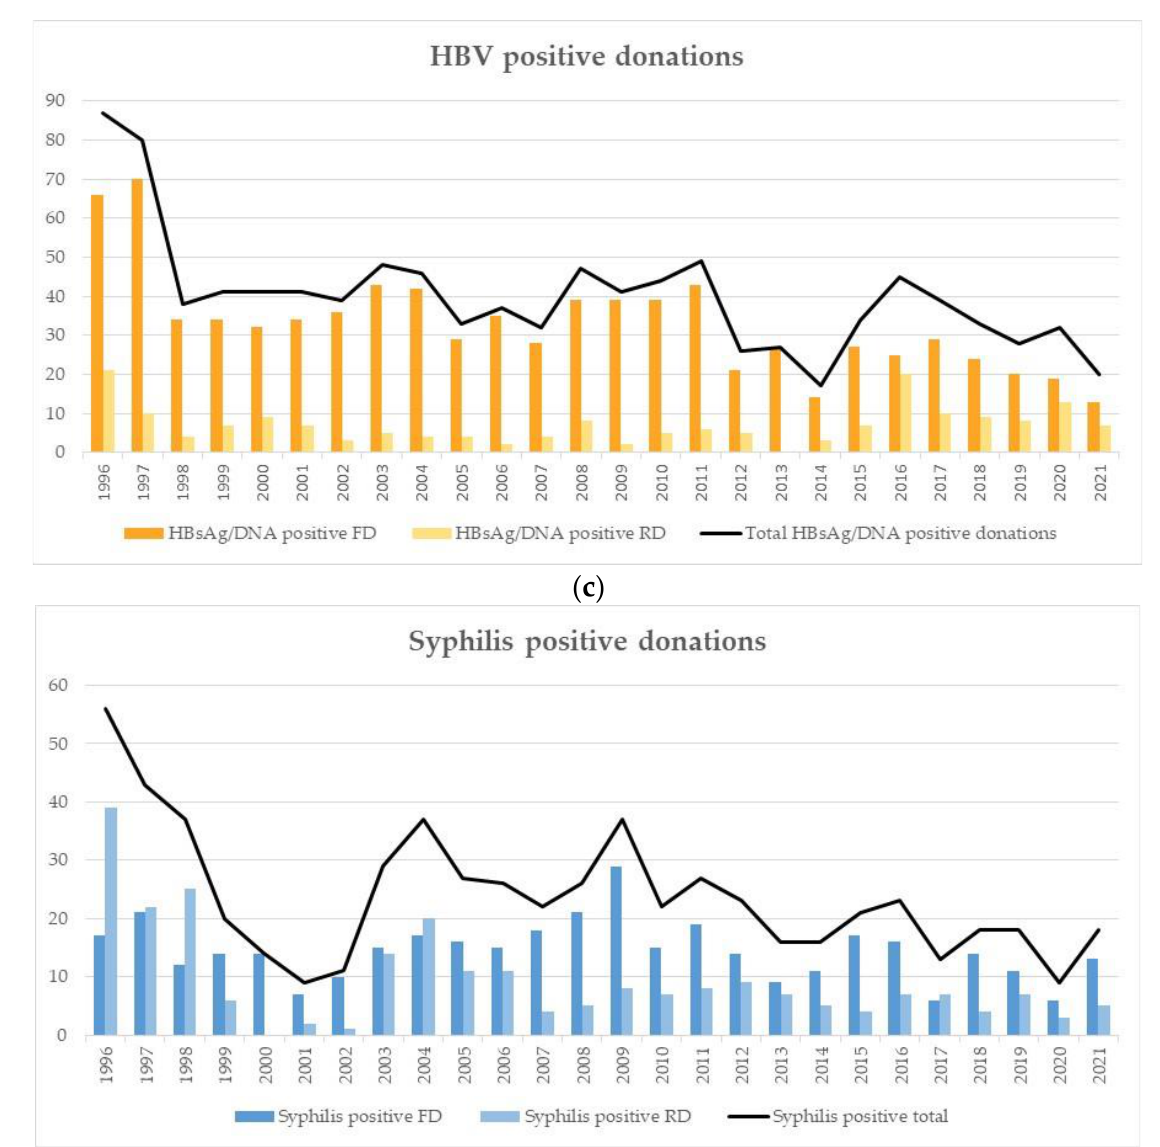
Figure 2. ( a ) HCV confirmed positive donations for RDs and FDs. ( b ) HIV confirmed positive donations for RDs and FDs. ( c ) HBV confirmed positive donations for RDs and FDs. ( d ) Syphilis confirmed positive donations for RDs and FDs.